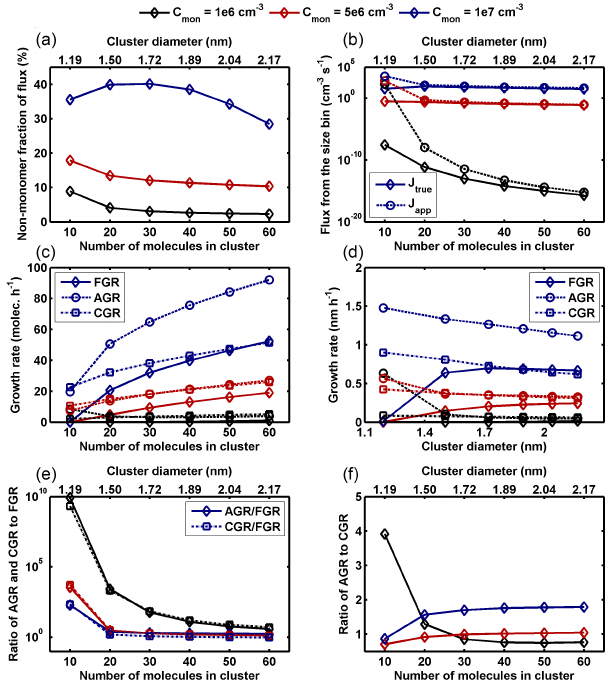
Figure 1. The effect of steady-state monomer concentration (shown as different colors) on quantities describing cluster growth: (a) the non-monomer fraction of flux from each size bin; (b) the true collision–evaporation flux from each size bin ( J true ; solid line) and the fluxes calculated from the appearance times of clusters ( J app ; dashed line); (c, d) the flux-equivalent growth rate (FGR; solid line), the growth rate derived from the appearance times of clusters (AGR; dashed line), and the growth rate calculated based on irreversible va- por condensation (CGR; dotted line); (e) the ratios of AGR to FGR (solid line) and CGR to FGR (dotted line); (f) the ratio of AGR to